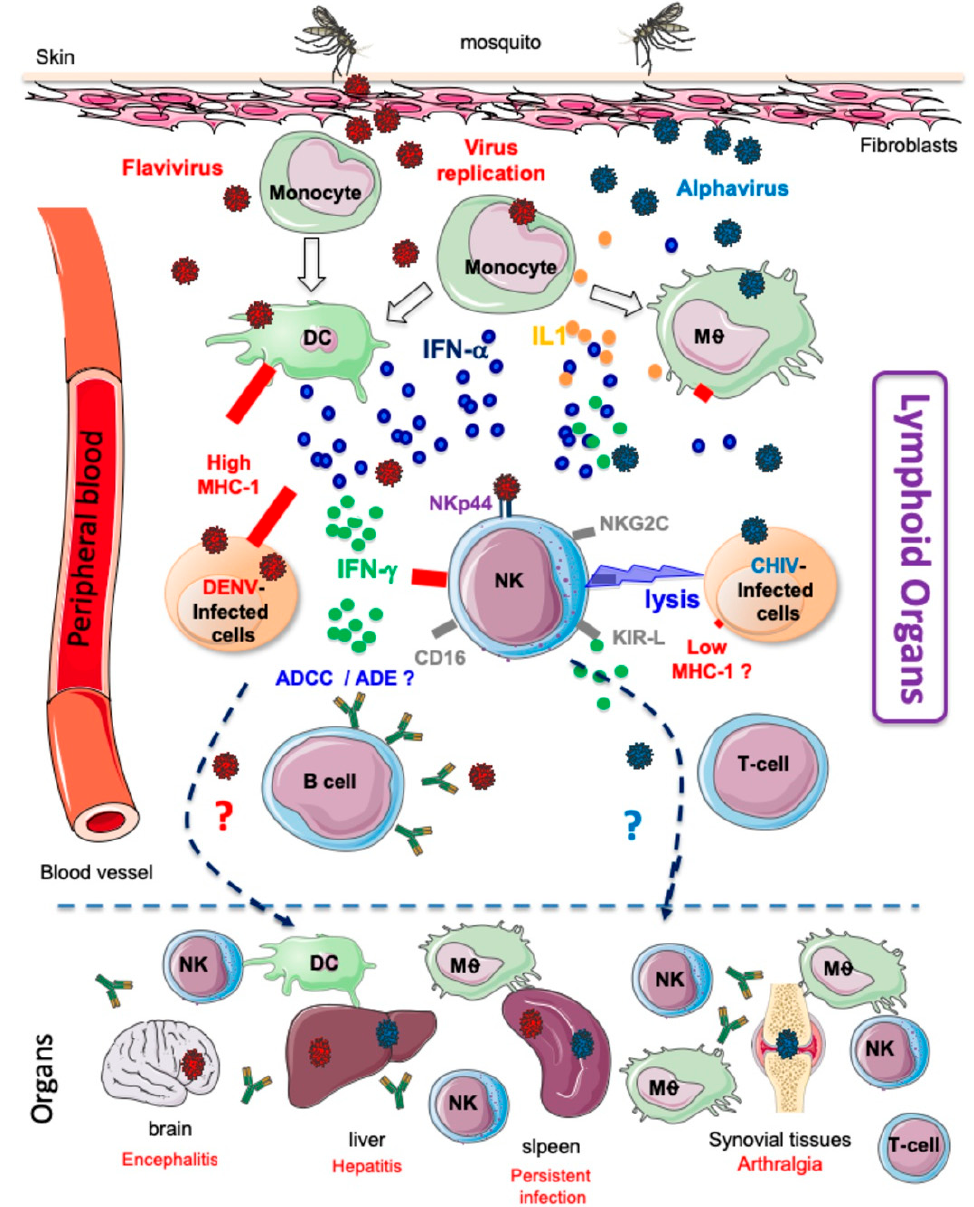
Figure 2. Virus dissemination, immune activation and clinical manifestations in patients infected by alphavirus or flavivirus. These viruses are transmitted through the bite of a female mosquito. The virus infects susceptible cells of the dermis, such as endothelial cells, fibroblasts and macrophages. Locally produced viral particles are then transported through the circulation to secondary lymphoid organs. This acute phase of infection is associated with the upregulation of the production of proinflammatory cytokines, such as IL-1 β and IFN- α , that induce innate immune responses, including those exerted by NK cells. Through the circulation alphavirus or flavivirus disseminated also to different organs, including the brain, spleen, liver, joints and muscles. Peripheral and tissue-resident NK cells can directly fight infected cells by triggering cytotoxicity (alphaviruses) or massive production of IFN- γ (flaviviruses), which contributes to the control of infection and the generation of adaptive T cell immunity, as well as the production of protective antibodies and the induction of antibody-dependent cellular cytotoxicity. For other flaviviruses, such as DENV, antibody complexes are also associated with the triggering of antibody-dependent enhancement which has been linked to the development of more severe forms of disease.